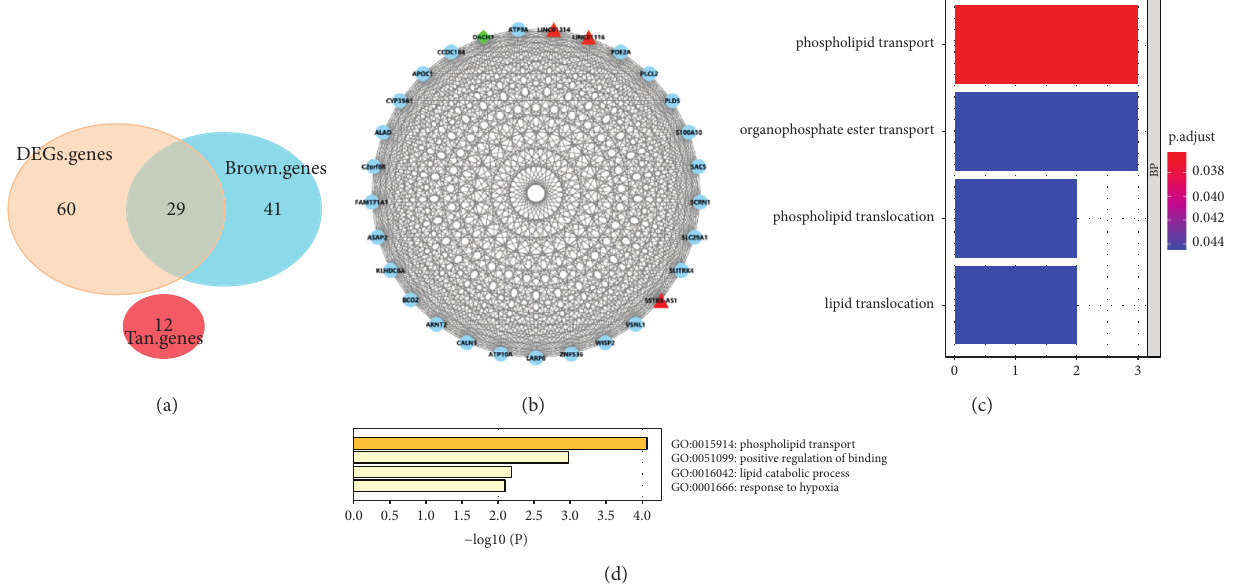
Figure 4: Identification of real hub genes and functional enrichment. (a) The Venn diagram of DEGs of the combined dataset and hub genes from the brown and tan modules. Twenty-nine real hub genes were identified. (b) The interaction network of lncRNA, transcription factor, and coding mRNA for the real hub genes. The red triangles represent lncRNA, the green diamond represents the transcription factor, and the other light blue circles represent the protein coding genes. (c), (d) The results of functional enrichment analysis using the clusterProfiler package and Metascape database. Phospholipid transport was enriched in both methods.